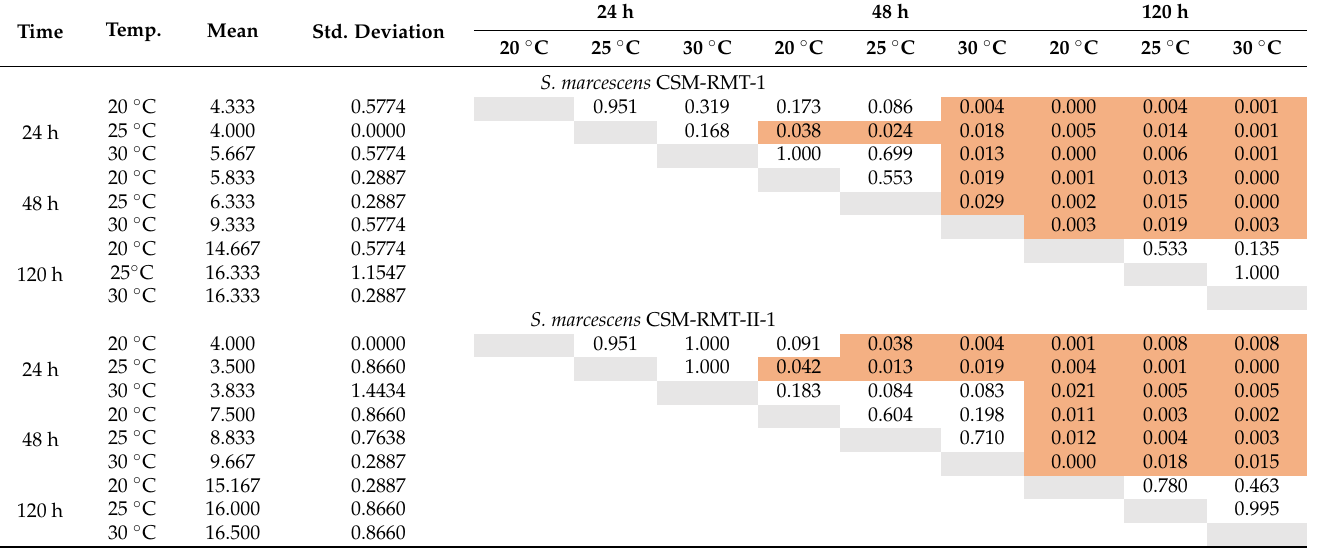
Table 4. Statistical results of protease activity in the case of S. marcescens CSM-RMT-1 and S. mar- cescens CSM-RMT-II-1 .